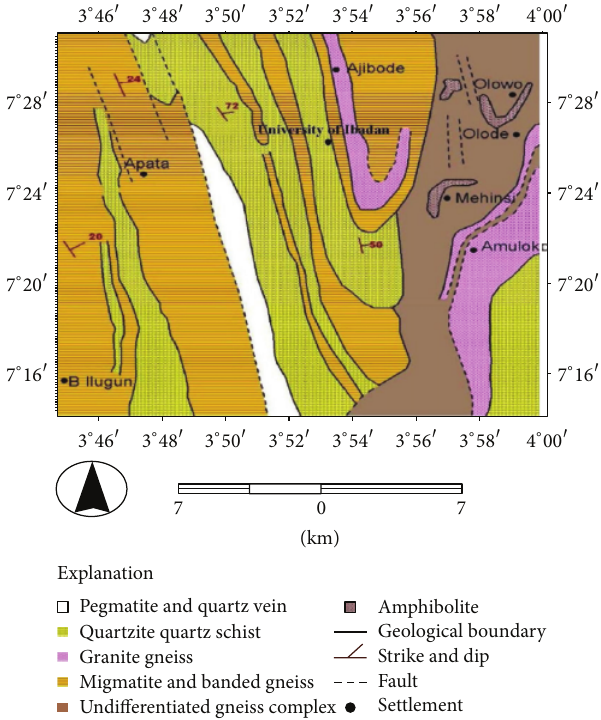
Figure 1: Generalized geological map of Ibadan [23].